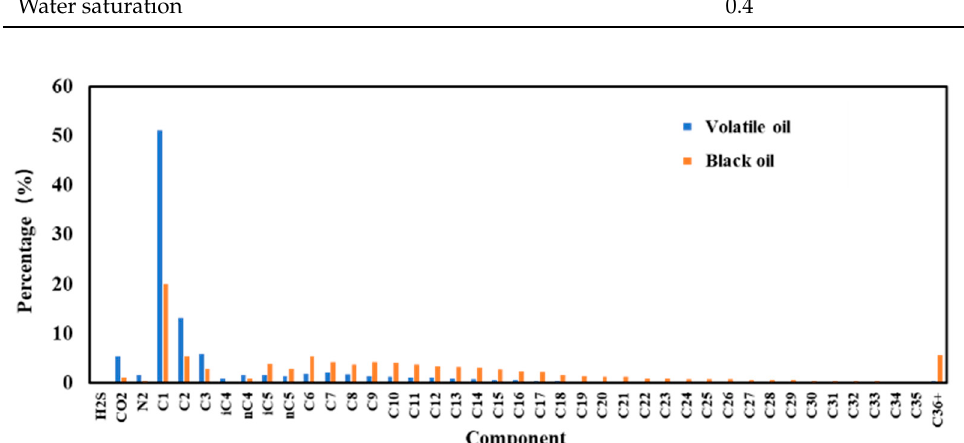
Figure 5. The mole percentage of volatile oil (horizontal well in the basin center) and black oil (hor- izontal well away from the basin center) components. Table 1. Model parameters of the one-stage fractured horizontal well.